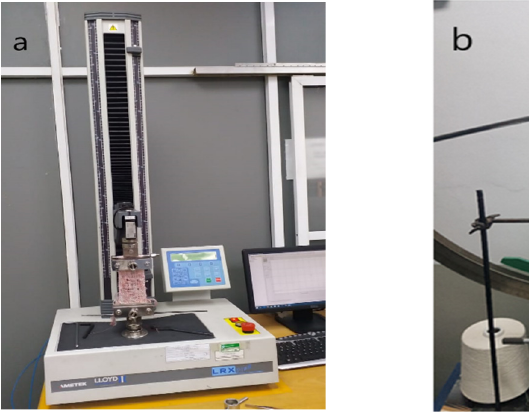
Figure 3. Fabric tensile testing machines: ( a ) Tensile and puncture resistance machine; ( b ) Out-of- plane auxeticity test machine; ( c ) the energy absorption